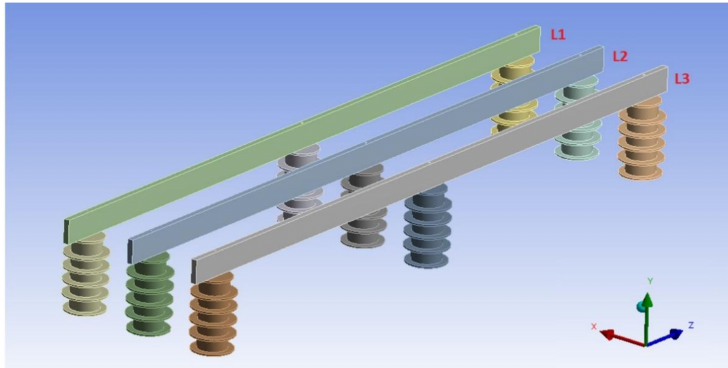
Figure 9. EIPB system drawn in ANSYS with the same geometry as for analytical